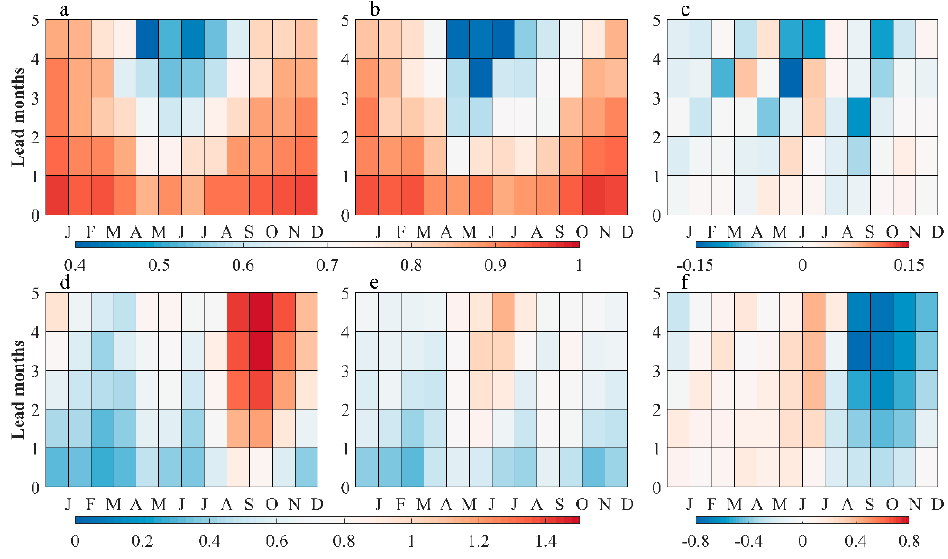
Figure 4. The ACC and RMSE of the Niño 3.4 index forecast skill for all the target months and lead months obtained using the FIO − ESM − CPS ( a , d ); modified FIO − ESM − CPS ( b , e ); the differences between modified and original FIO − ESM − CPS ( c , f ) (unit: 1).